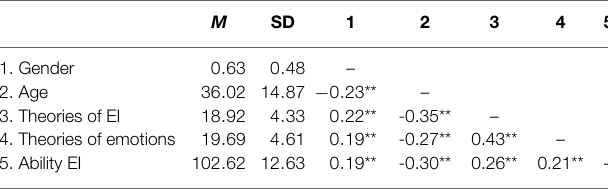
TABLE 1 | Descriptive statistics and correlations.